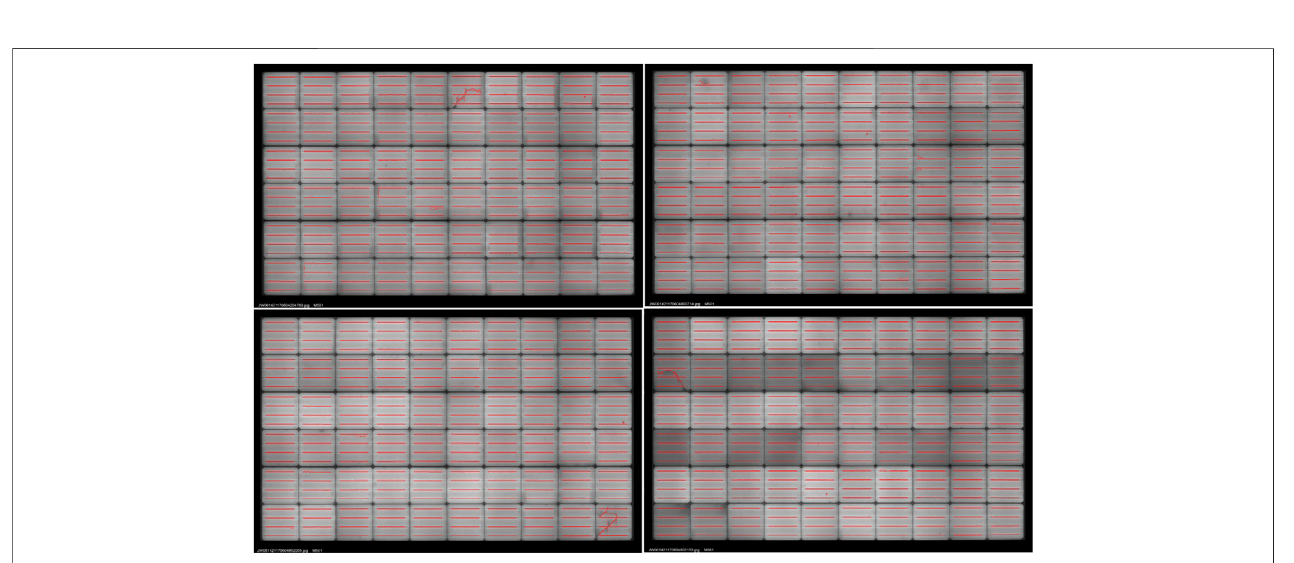
FIGURE 9 | The effect diagram obtained by using the Canny operator